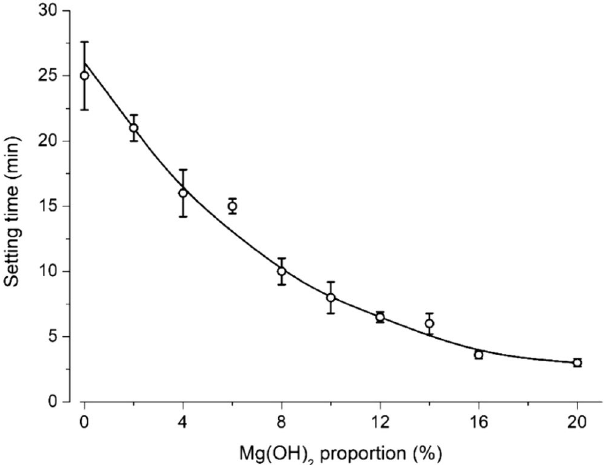
Figure 1. Initial setting times of slurries prepared by incremental replacement of dead-burned magnesia with Mg(OH)